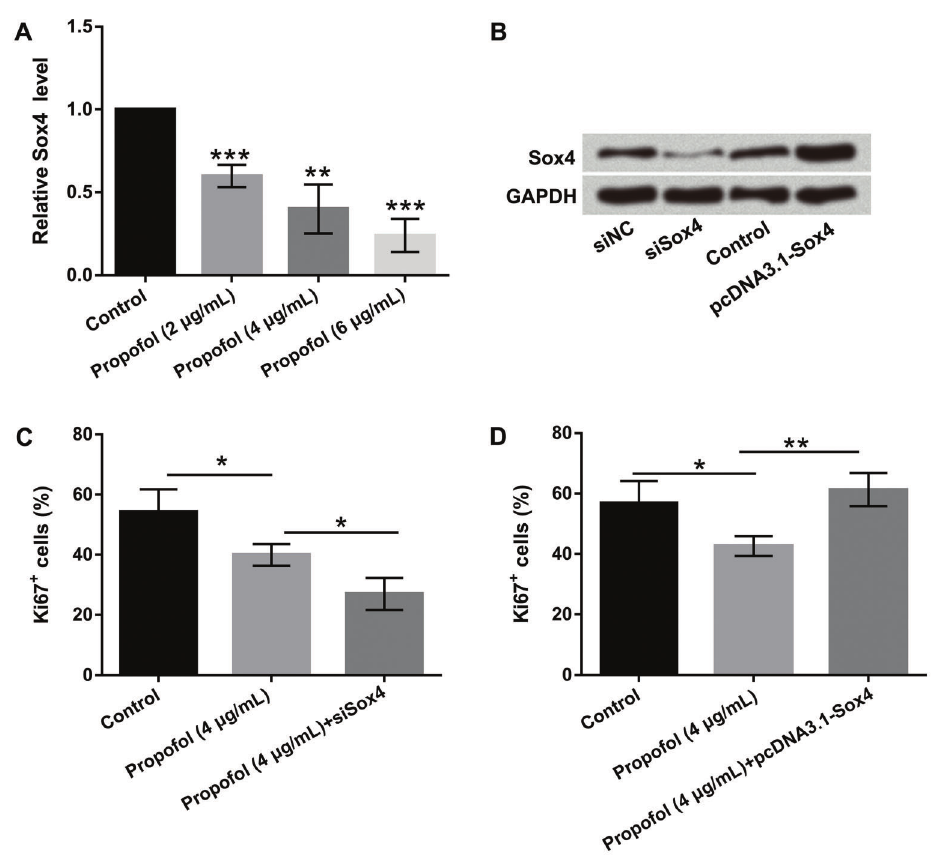
Figure 4. Propofol inhibited cell proliferation by regulation of Sox4 in Ishikawa cells. Human EC Ishikawa cell line was exposed to different concentrations of propofol (2, 4, and 6 m g/mL) for 24 h and ( A ) the mRNA expression of Sox4 was detected by qRT-PCR. Then, pcDNA3.1-Sox4 and Sox4 siRNA were transfected into Ishikawa cells and ( B ) the protein level of Sox4 in overexpression and silencing of Sox4 were measured by and western blot. In C and D , the percentage of Ki67 + cells was analyzed by immunohistochemistry analysis. EC: endometrial cancer; Sox4: sex-determining region Y-box 4; siRNA: small interference RNA; qRT-PCR: quantitative real time PCR. Data are reported as means ± SD. *P o 0.05; **P o 0.01; ***P o 0.001 (ANOVA).